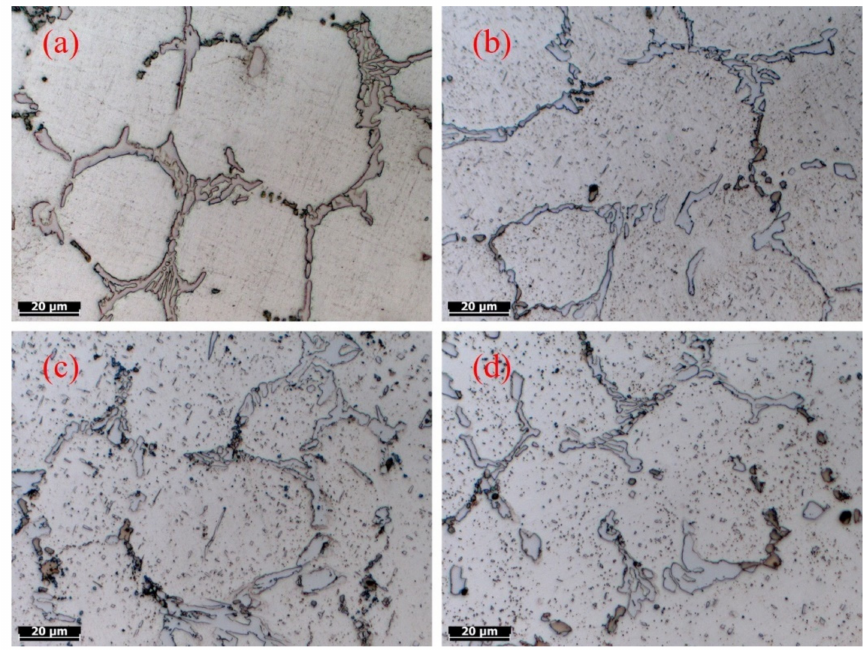
Figure 3. Typical optical microscopy images of ( a ) as-cast HP40Nb alloy and the specimens after aging at 990 ◦ C for ( b ) 500, ( c ) 2000, and ( d ) 4000